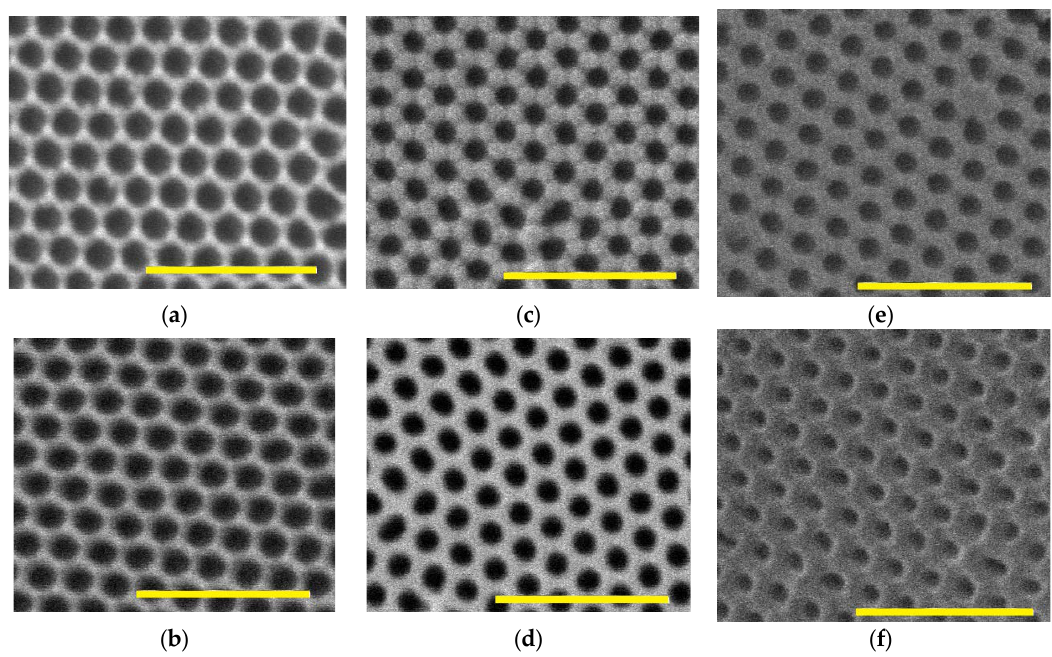
Figure 2. Visualization by scanning electron microscope (SEM) image of the reduction in pores diameter as the layers that make up the capacitor are successively deposited, overlapping one above the other. The left column represents the different stages of the conformation for the single layer capacitor, being ( a ) the micrograph made after the deposition of the BE; ( c ) the one taken after the placement of the Al 2 O 3 over the BE; and ( e ) the one that shows the membrane after the deposition of the BE, the Al 2 O 3 , and the TE. Likewise, the column on the right shows the three similar steps for the triple layer capacitor, being ( b ) the one corresponding to the BE deposition, ( d ) the one corresponding to the triple layer SiO 2 /TiO 2 /SiO 2 deposited over the BE, and ( f ) the one showing the whole BE-SiO 2 /TiO 2 /SiO 2 -TE capacitor structure completely deposited. Note the yellow scale bar of 500 nm for all images.